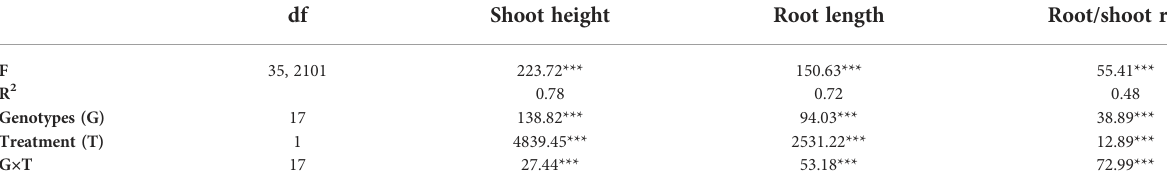
TABLE 2 Two-way ANOVA analysis of the effects of wheat cultivars and drought treatment on plant growth. df Shoot height Root length F R